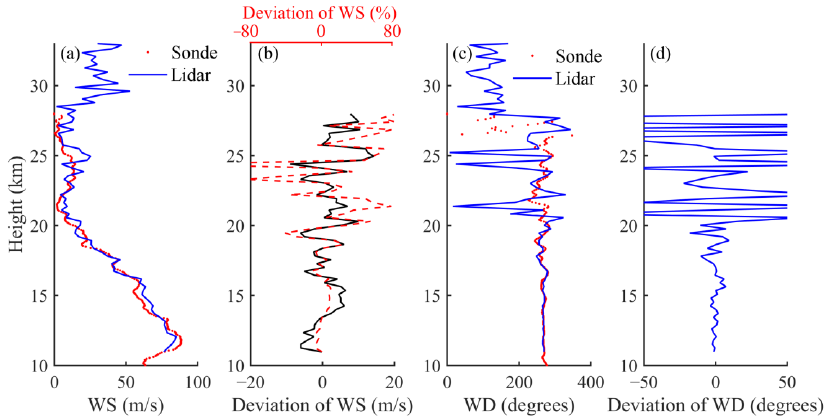
Figure 8. ( a , c ) Profiles of horizontal wind speed and direction measured by lidar (blue line) and radiosonde (red line). ( b , d ) Deviation between the two devices. radiosonde (red line). ( b , d ) Deviation between the two